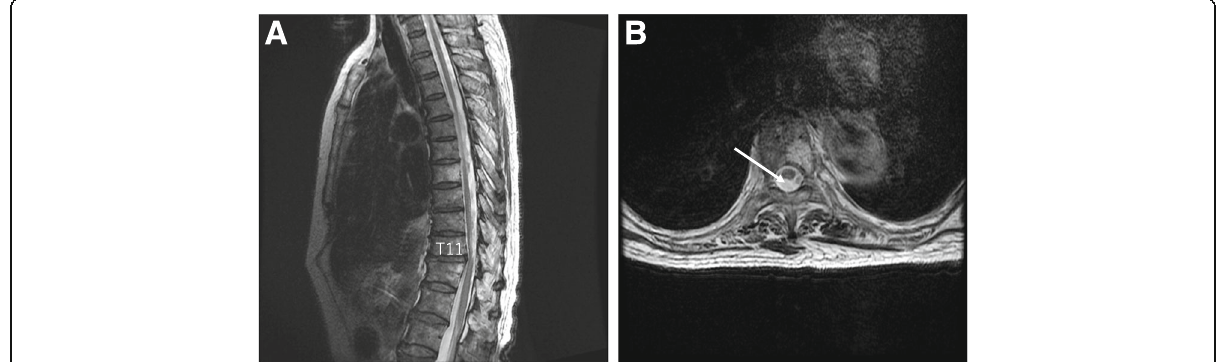
Fig. 4 a Sagittal MRI on postoperative day 93 demonstrated that the hyperintense region was localized to T11. b Axial MRI of the T8 spinal cord level. Scarring of the infarction occurred, and the fluid space was